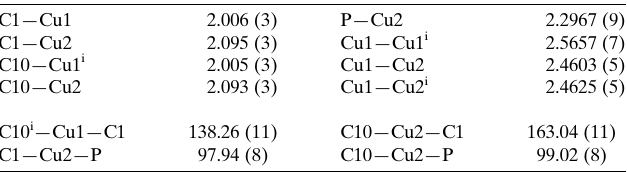
Table 1 Selected geometric parameters (A˚ , (cid:4) ).